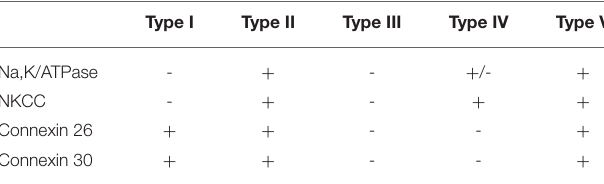
TABLE 1 | Summary of ion channels and proteins expressed in spiral ligament